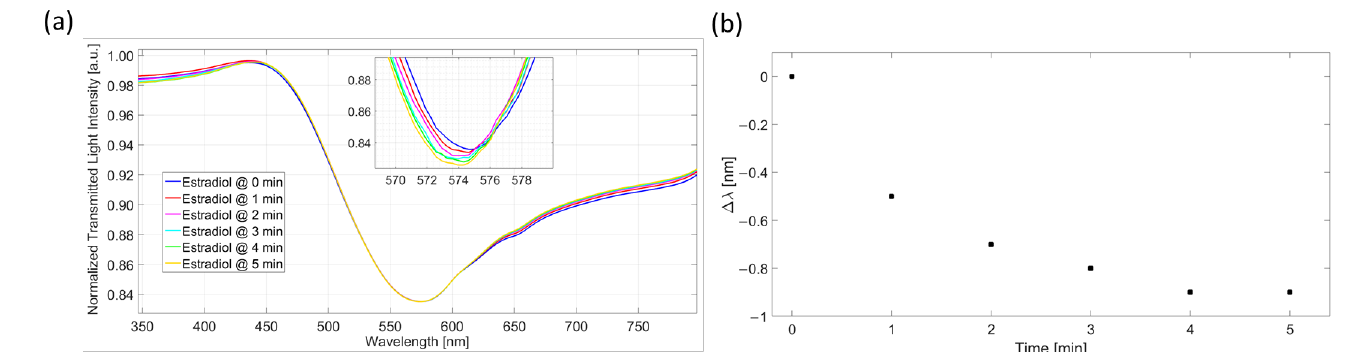
Figure 4. ( a ) Normalized SPR spectra obtained for estradiol (3.6 pM) at different incubation times on ER–SPR spoon-shaped probe. ( b ) Variation in the resonance wavelength (Δλ) as a function of incubation times with respect to initial time (t = 0).